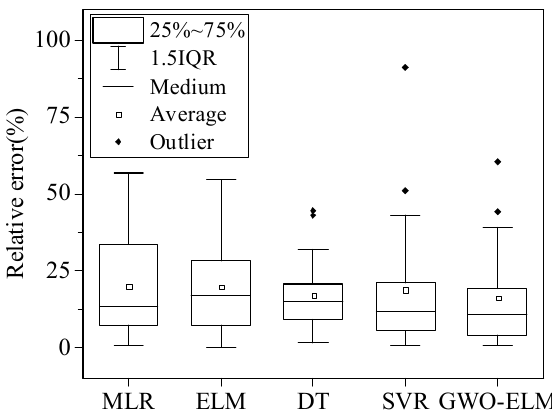
Figure 8. Prediction error distribution of different models for UCS.